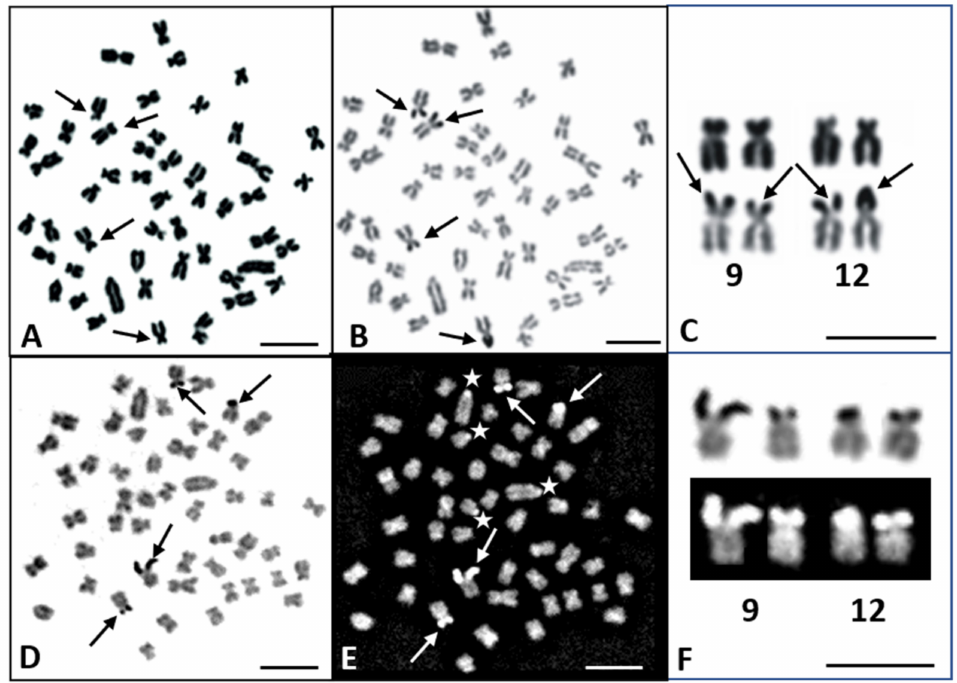
Figure 2. Metaphase plates of the common nase ( Chondrostoma nasus ) with 2 n = 52 chromosomes ( A , B ) and 2 n = 50 chromosomes ( D , E ) stained with Giemsa ( A ) and sequentially using AgNO 3 ( B ); stained with AgNO 3 ( D ) and sequentially with CMA 3 ( E ); silver nucleolar organizer regions (Ag-NORs) ( C ) and CMA 3 -positive ( F ) sites on the chromosome pairs No. 9 and 12. Arrows indicate: Ag-NOR carrying chromosomes ( A ); Ag-NOR sites ( B , C , D ) and corresponded CMA 3 -positive sites ( E ). Stars indicate other CMA 3 positive sites ( E ). (Bar = 10 µ m).